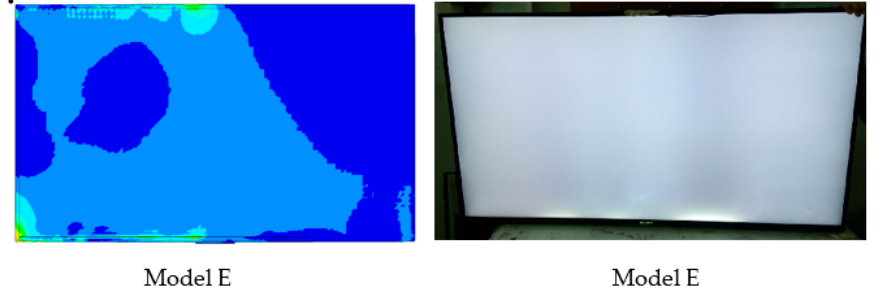
Figure 7. Drop-test results.